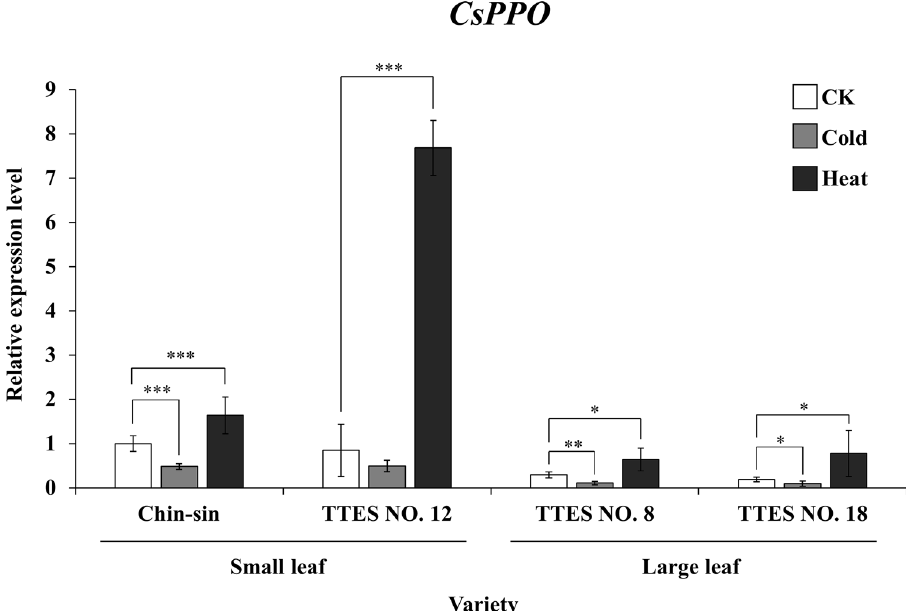
Figure 4. CsPPO regulation by different abiotic stress in small- and large-leaf varieties. One-year-old seedlings of different varieties were subjected to CK (22 °C), cold (4 °C), and heat (35 °C) stress treatments. Total RNA was extracted from the young leaves of each sample. CsPPO transcript levels were measured using qRT-PCR and normalized to that of 18S rRNA. Values are presented as the mean ± SD of four biologically independent experiments (N = 4, n = 4). Asterisks indicate significant differences between treatments assessed using the LSD post-hoc test (* p < 0.05, ** p < 0.01, *** p <